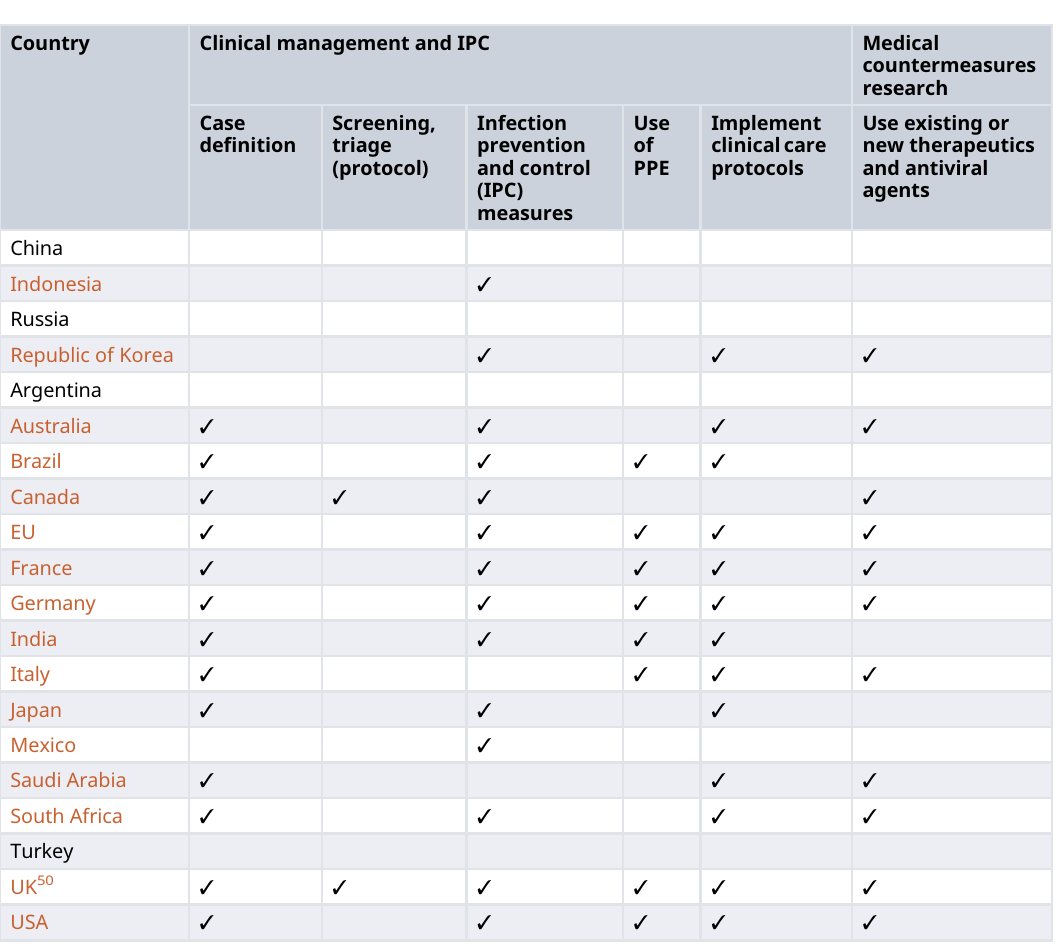
Table 5. Clinical management and IPC and Medical countermeasures